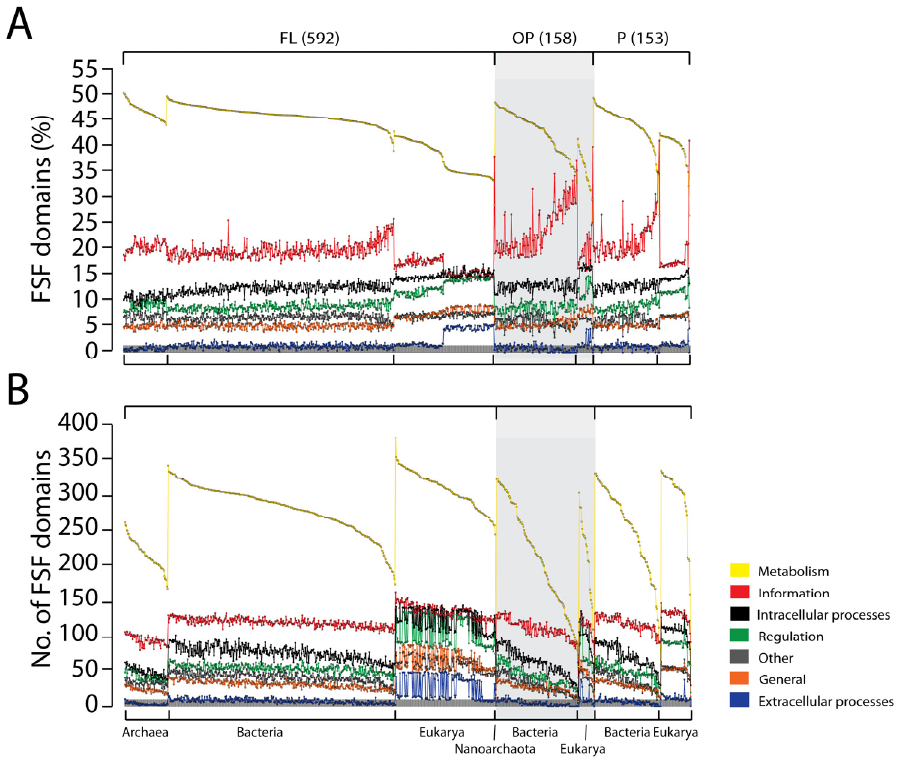
Figure 3. The functional distribution of FSFs with respect to organism lifestyle. Both the percentage ( A ) and actual FSF numbers ( B ) indicate that obligate parasitic (OP) and facultative parasitic (P) organisms exhibit considerable variability in their metabolic repertoires (yellow trend lines) that is offset by corresponding increases in the Information FSFs (red trend